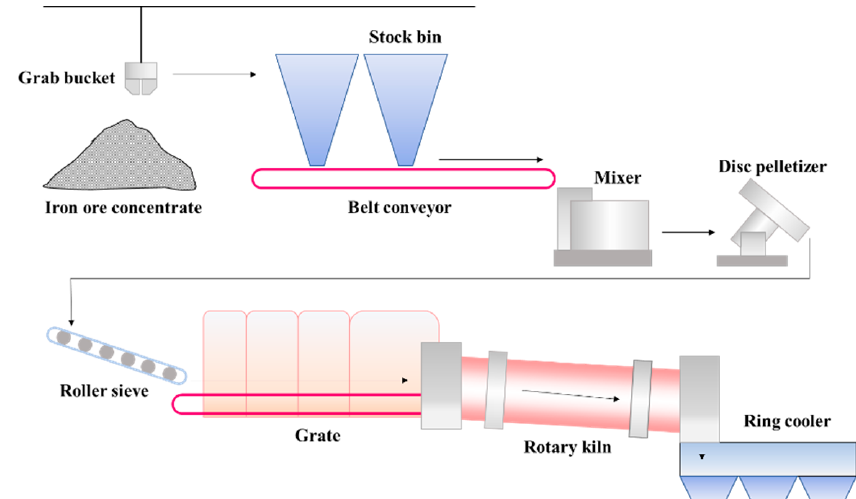
Figure 1. Schematic diagram of the grate-kiln technological process. 2.2. The Distribution of Deposit in Coal-Fired Rotary Kiln The distribution of deposits in a grate and rotary kiln is mainly affected by pulverized coal injection and temperature field [21,22]. As shown in Figure 2, at the heads of the rotary kiln, pulverized coal is sprayed with high-pressure air and burned to provide heat for the drying, oxidation and consolidation of pellets. In addition, the high-temperature exhaust gas from the cooler serves as the secondary air to provide a stable temperature field for the grate and the rotary kiln [23]. Influenced by the flame shape generated by pulverized coal combustion, the temperature in the middle of the rotary kiln is usually higher than that in the head and tail of the kiln [24,25]. Therefore, the deposit-forming phenomenon in the middle of the kiln is more pronounced. In previous experiments, we selected the sediments from different regions of the grate and rotary kiln for chemical element composition analysis, as shown in Table 1 [2,26]. The obtained results indicate that the total iron content from K1 to K7 showed a decreasing trend, while the contents of K, Na and Si increased gradually. This study confirmed that the distribution regularity of chemical composition of deposit in the rotary kiln was mainly affected by pulverized coal injection. The residual coal ash produced by pulverized coal combustion is driven by hot air to the kiln tail, which makes the deposit in the K4-K7 region contain more coal ash components, while the chemical composition of the deposit in the K1-K3 region is similar to pellets.